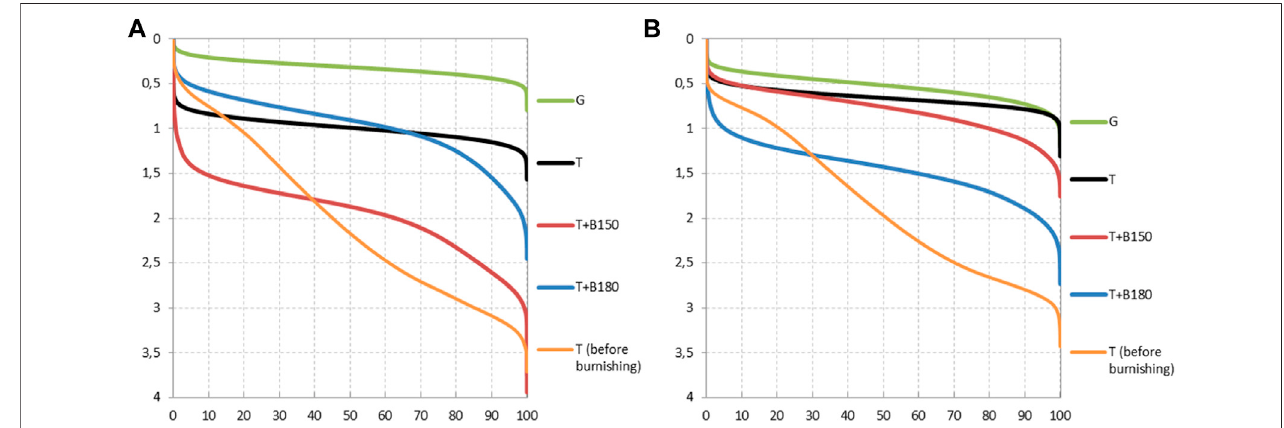
FIGURE 7 | Material ratio curves after mechanical processes of surface layer modi fi cations for: (A) Vanadis 8, (B) Vancron 40 steels.